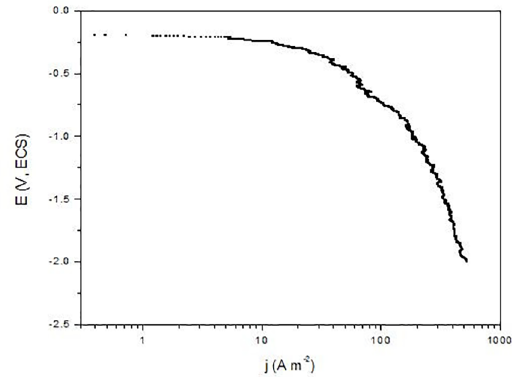
Figure 1. Cathodic polarization curve of carbon steel substrate obtained from the solution containing Cu (II) and Sn (II) ions, as well as sodium tartrate as the complexant agent.